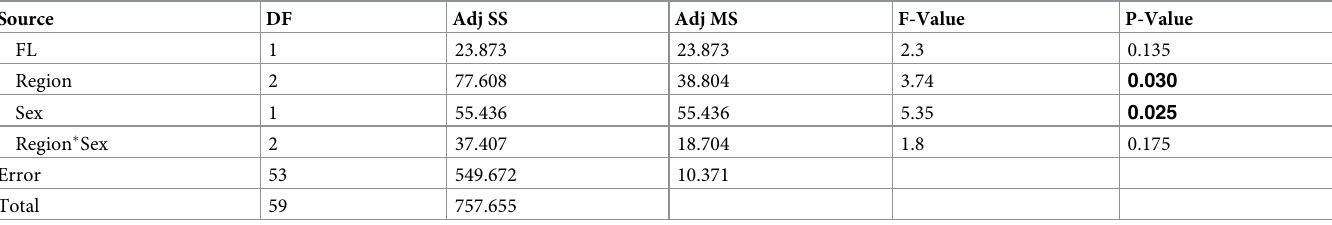
Table 2. General linear model results on square-root transformed maximum rate of movement.